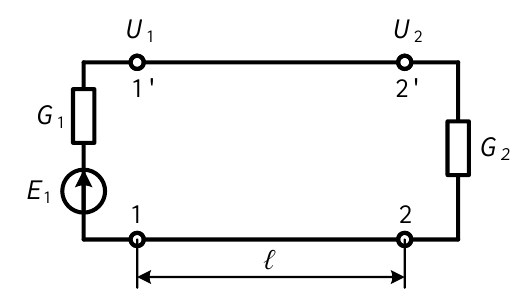
Figure 2. The equivalent circuit of conductive and wireless connections between electronic devices